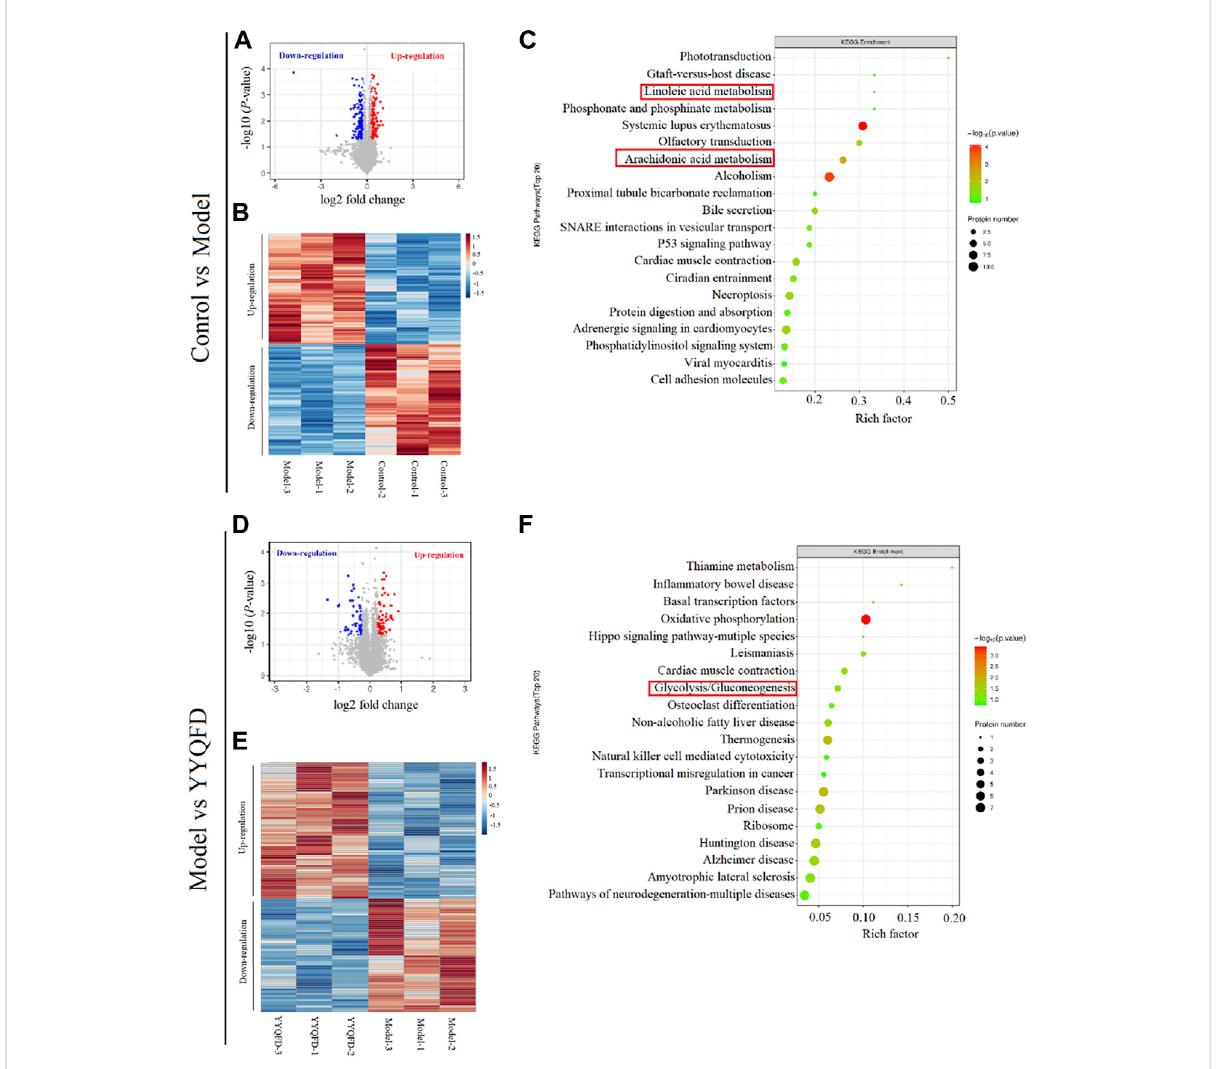
FIGURE 5 TheeffectofPM 2.5 exposureandYYQFDinterventiononproteomicpro fi lesinlungtissue (A,BandC) Modelgroupvs.Controlgroup (D,EandF) YYQFT group vs. Model group (A) and (D) Volcano plots of detected protein (B) and (E) Heatmap analysis of signi fi cantly differentially expressed proteins (C) and (F) KEGG enrichment pathways of differential proteins.